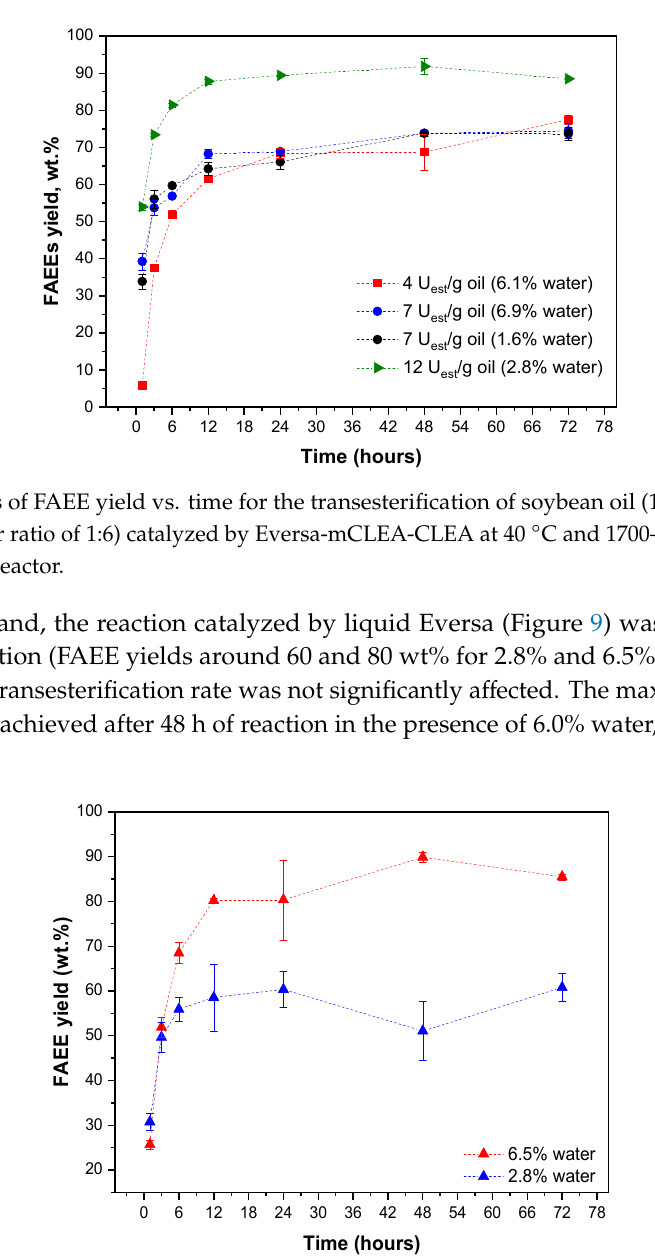
Figure 9. Profile of FAEE yield vs. time for the transesterification of soybean oil (15 g) with ethanol (oil/ethanol molar ratio of 1:6) catalyzed by liquid Eversa at 40 °C and 1700–2000 rpm stirring in a vortex flow reactor using an enzyme load of 7 U est /g oil.